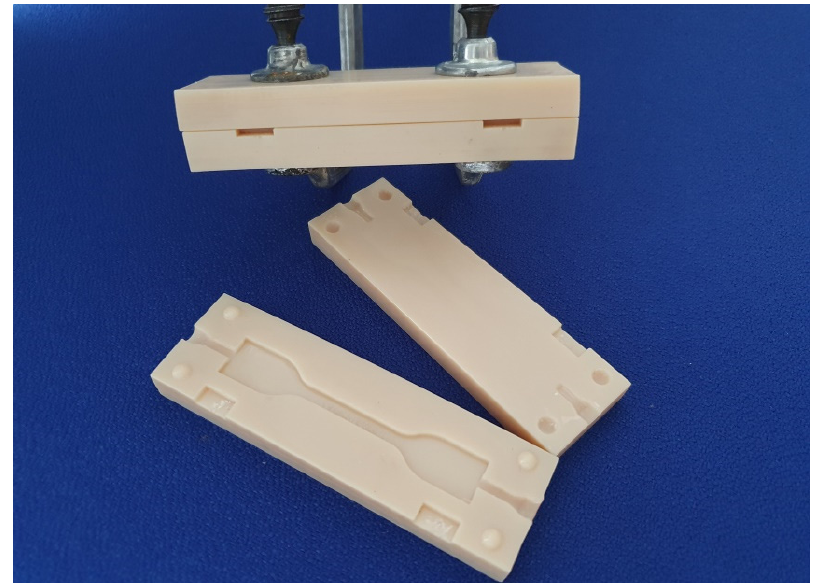
Figure 4. 3D-printed injection mold for the S2 dumbbell specimens (For S2 dumbbell Injection